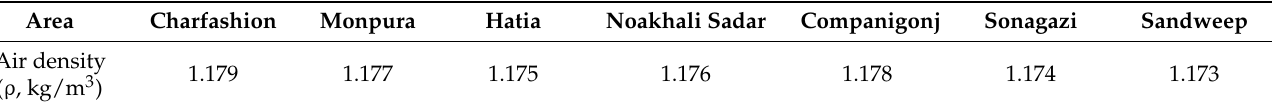
Table 6. Average air density for the selected coastal sites.